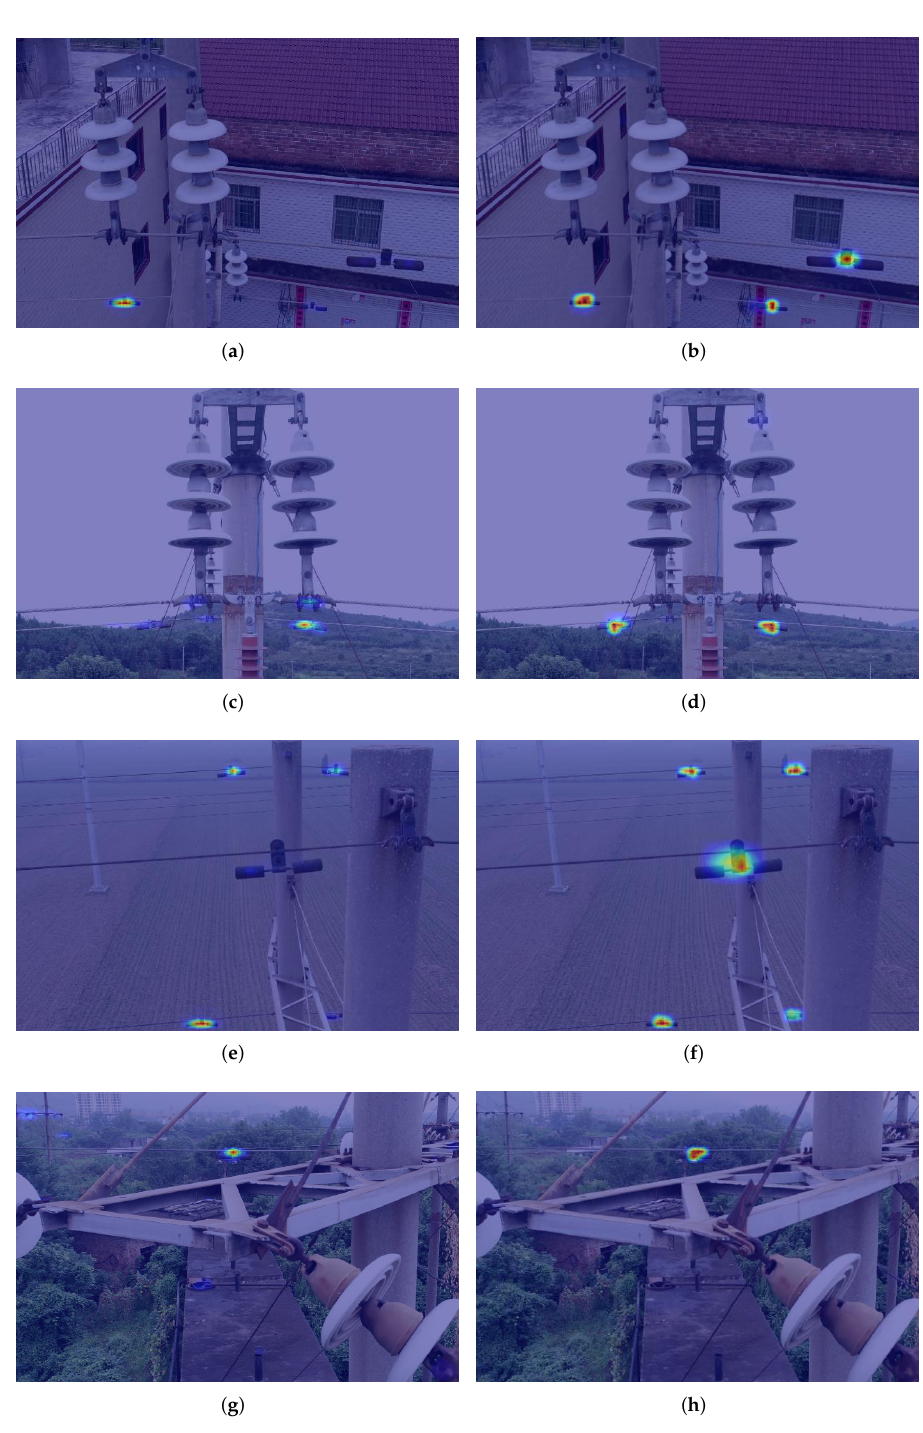
Figure 14. Feature heat maps of the results in Figure 13, where ( a , c , e , g ) are the results without the mechanism, ( b , d , f , h ) are the results of using the